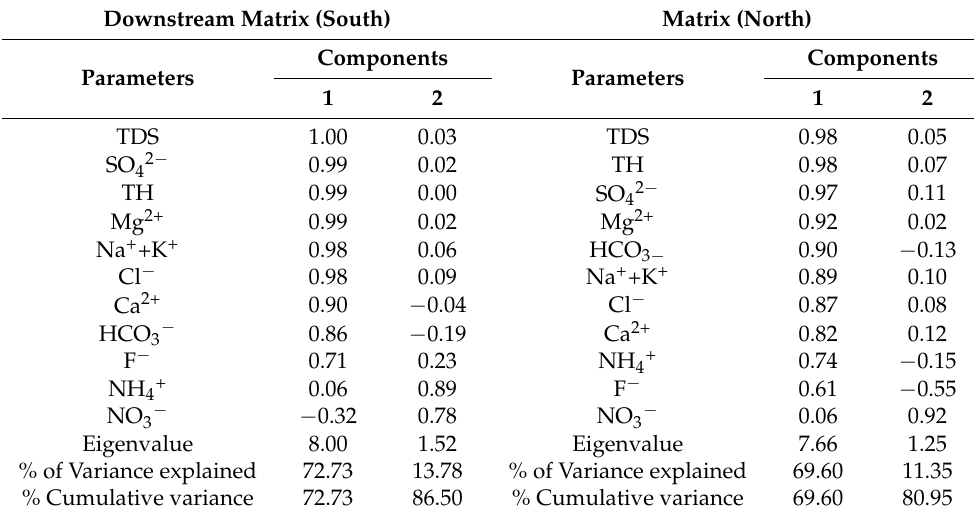
Table 6. Load matrix of the main